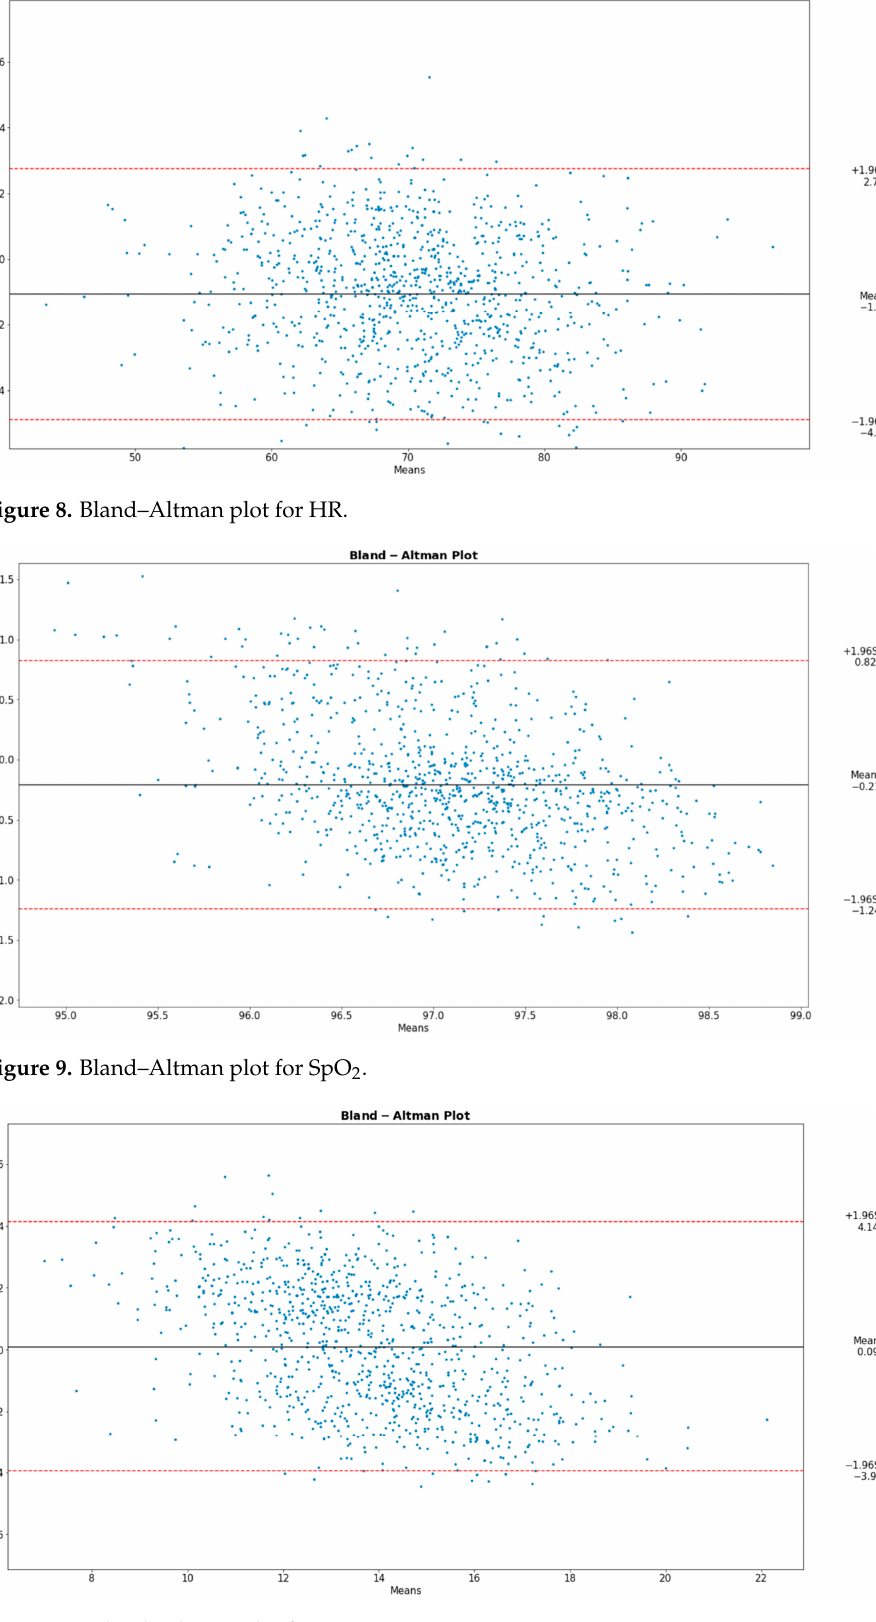
Figure 10. Bland–Altman plot for RR.